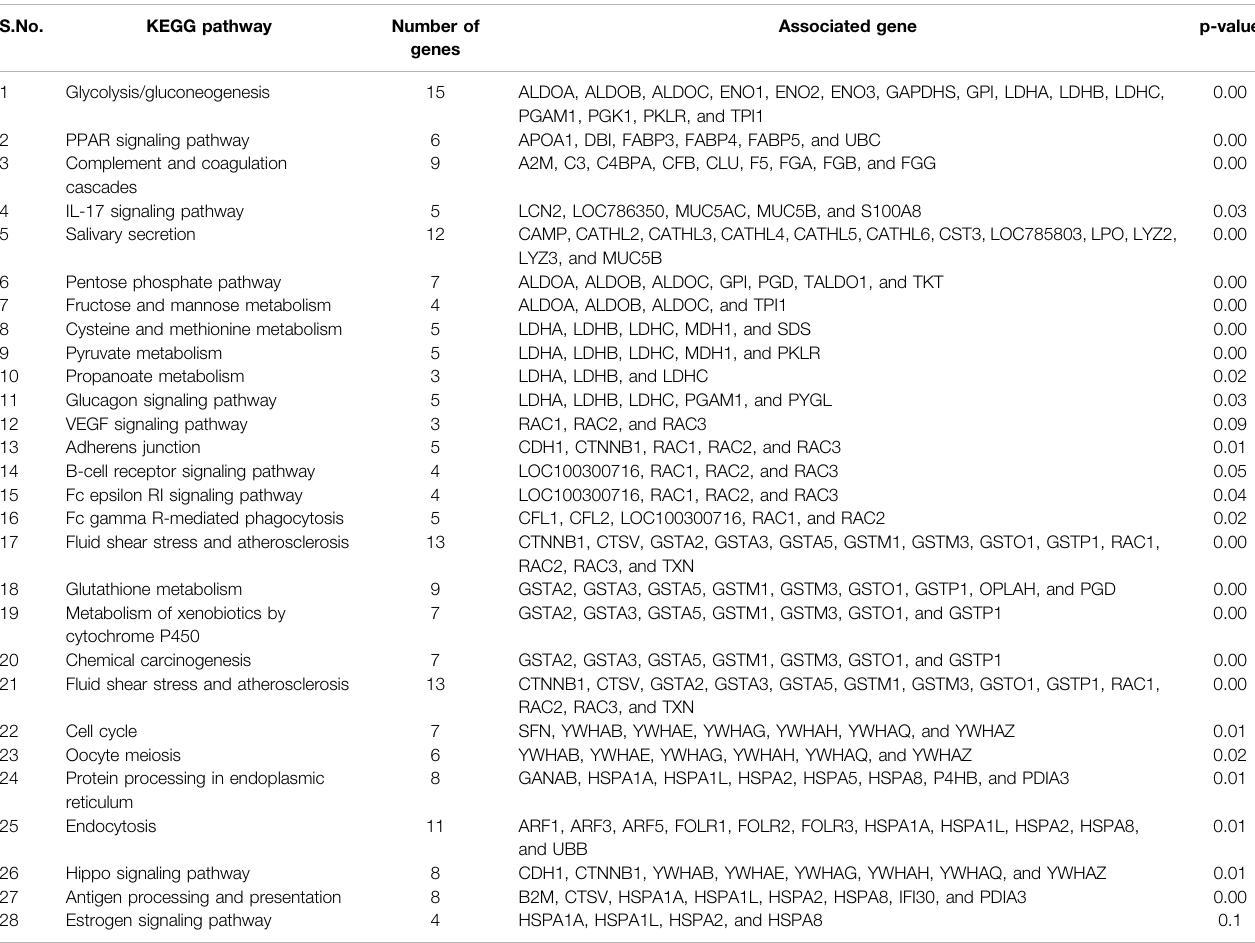
TABLE 6 | Involvement of differentially expressed proteins (DEPs) in KEGG pathways.